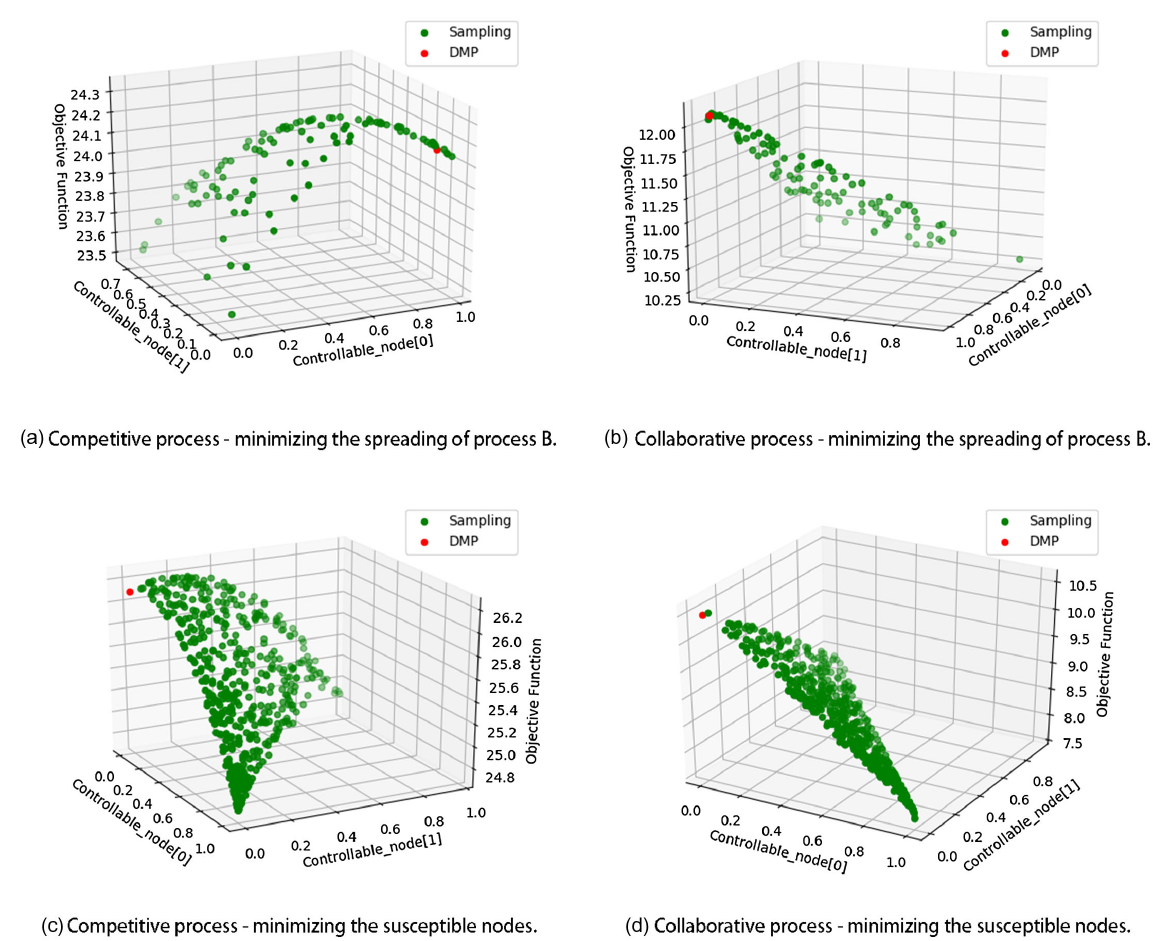
FIG. 5. Comparison of results obtained using the DMP-based optimization method and random sampling in parameter space. (a) Competitive process with a time window T ¼ 3 and infection probabilities α A ¼ 0 . 5 and α B ¼ 0 . 5 . Sampled values for the various control parameters are marked by green points, while the DMP-optimal value is marked by a red point. Nodes 0, 28, and 19 were infected by process A as controllable nodes, with a total budget of one, while the fixed seed for process B is node 3. The objective, in this P P B T Þ . The DMP-based optimization maximizes the objective function case, is to contain the spread of process B , namely, minimize i i ð as 24.17, while the optimal sampling result is 24.1. (b) Similar experiment to panel (a), with the same conditions and objective, for the collaborative process with double infection parameters α AB ¼ 0 . 8 and α BA ¼ 0 . 8 . The DMP-optimal objective value is 12.11 against 12.1 from sampling. (c) Competitive process using the time window and infection parameters as in panel (a) but a different objective P ( 1 − P S T Þ ) . Controllable nodes are 6, 8, and 15, and node 3 is infected by process B . The function — maximizing the infection i i ð optimal DMP objective function value is 26.11 against 26.2 from sampling. (d) Similar experiment to panel (c) for the collaborative process with double infection parameters as in panel (b). The DMP-optimal result is 10.32 and 10.3 from